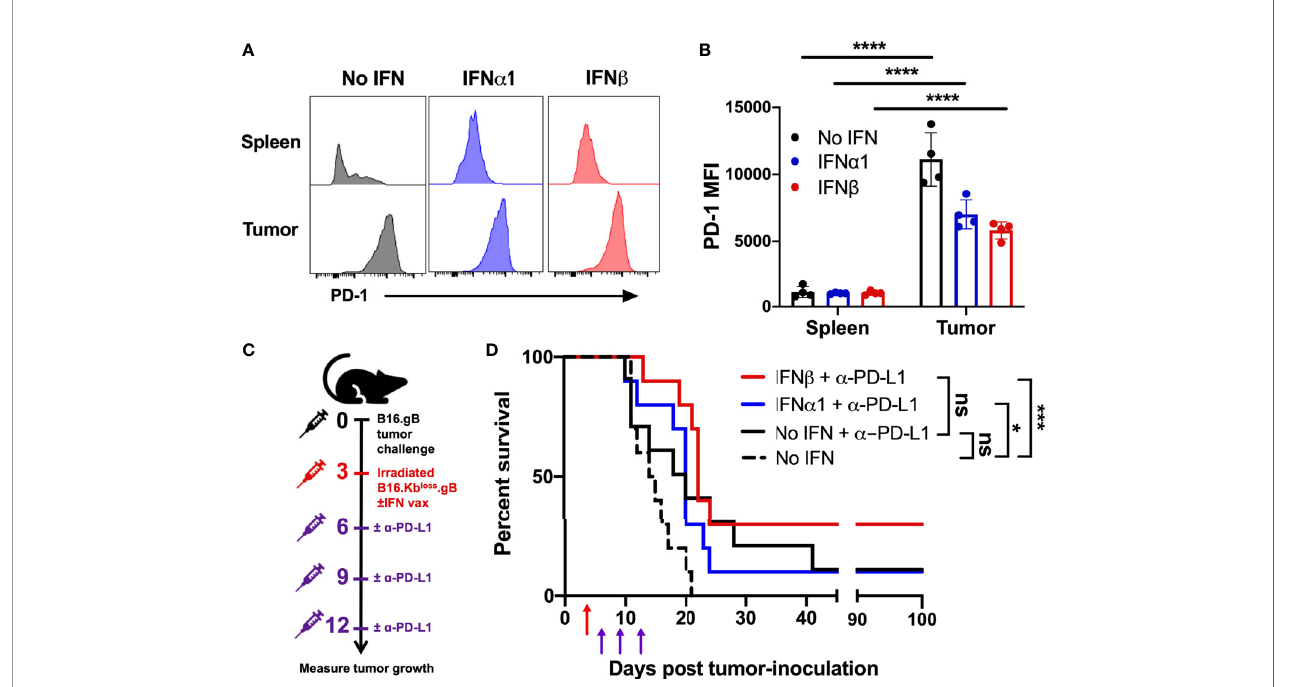
FIGURE 4 | Vaccination with IFN b improves overall survival in combination with anti-PD-L1 checkpoint blockade therapy. Mice were vaccinated with 2.5 x 10 6 irradiated B16.Kb loss .gB ± IFN cells three days post-B16.gB tumor inoculation. (A, B) Representative histograms (A) and mean fl uorescence intensity (MFI) (B) of PD-1 expression on transferred transgenic CD8 + T cells (gBT.I) from mice harvested seven days post-vaccination (n = 4 per group). (C, D) Experiment schematic (C) and survival curves (D) of mice receiving vaccination ± three doses of anti-PDL1 treatment (200 µg/dose) on days six, nine and twelve post-tumor challenge (n = 10 per group from two independent experiments). Dashed black line indicates the no IFN group from the vaccination alone cohorts in Fig 3c, as these data belong to the same experiment but were separated for clarity. Data was analysed by two-way ANOVA, comparing tumor to spleen (B) or Log-rank Mantel-Cox test (D) , ****p < 0.001 ***p < 0.005, *p < 0.05, ns, not signi fi